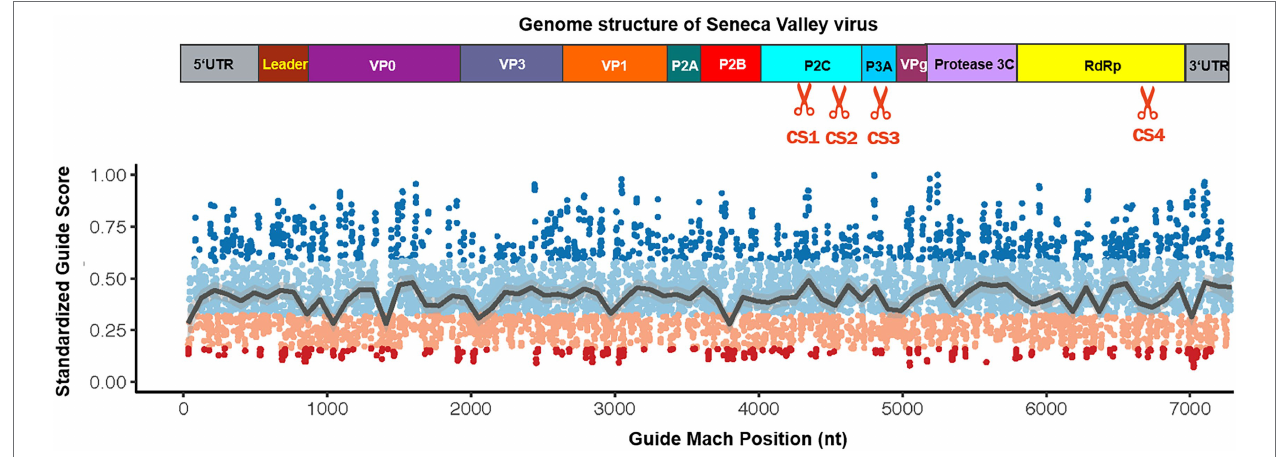
FIGURE 1 | Schematic diagram depicting the guide RNA match position in the Seneca Valley virus (SVV) genome. Protein construction from the SVV genome transcript, which demonstrates the cleavage site of the most effective guide RNA in this study ( upper panel ). Depiction of the score distribution along SVV genome; high scores indicate a higher predicted knockdown efficacy (guide scores range between 0 and 1; lower panel ).